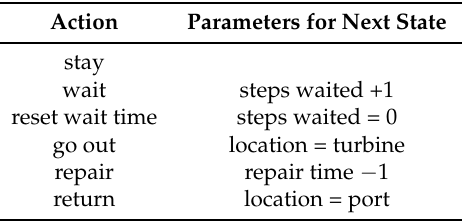
Table 2. The different actions and how they influence the parameters of the next